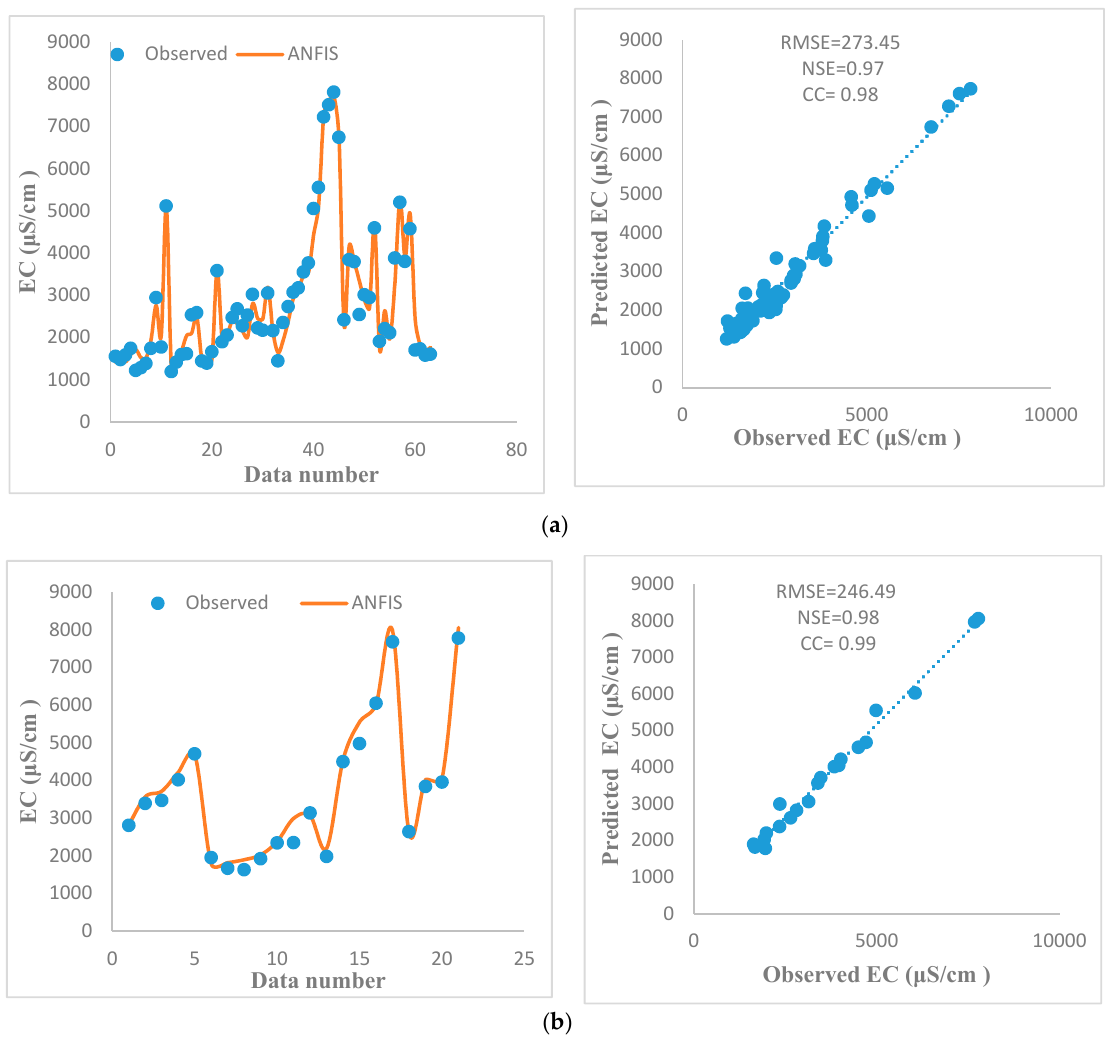
Figure 6. Comparative plots of observed and predicted electrical conductivity (EC) values using ANFIS model for ( a ) calibration data set and ( b ) validation. Table 4. Comparison of ANFIS, ANN and multiple linear regression (MLR) models performance.